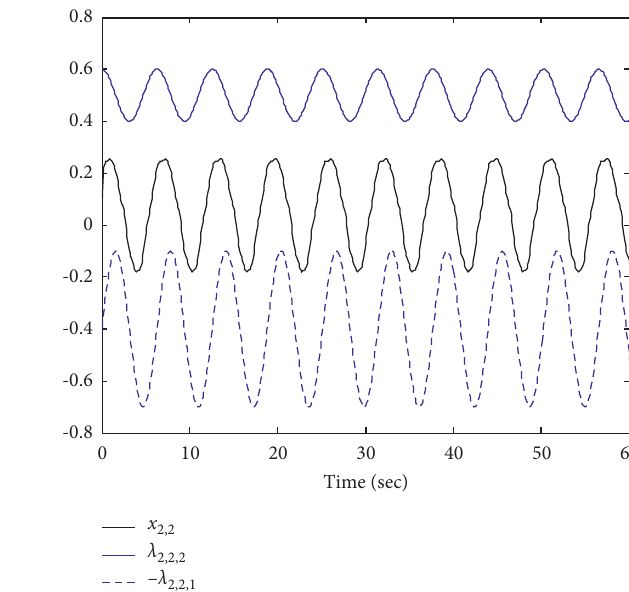
Figure 8: Trajectories of state variable x